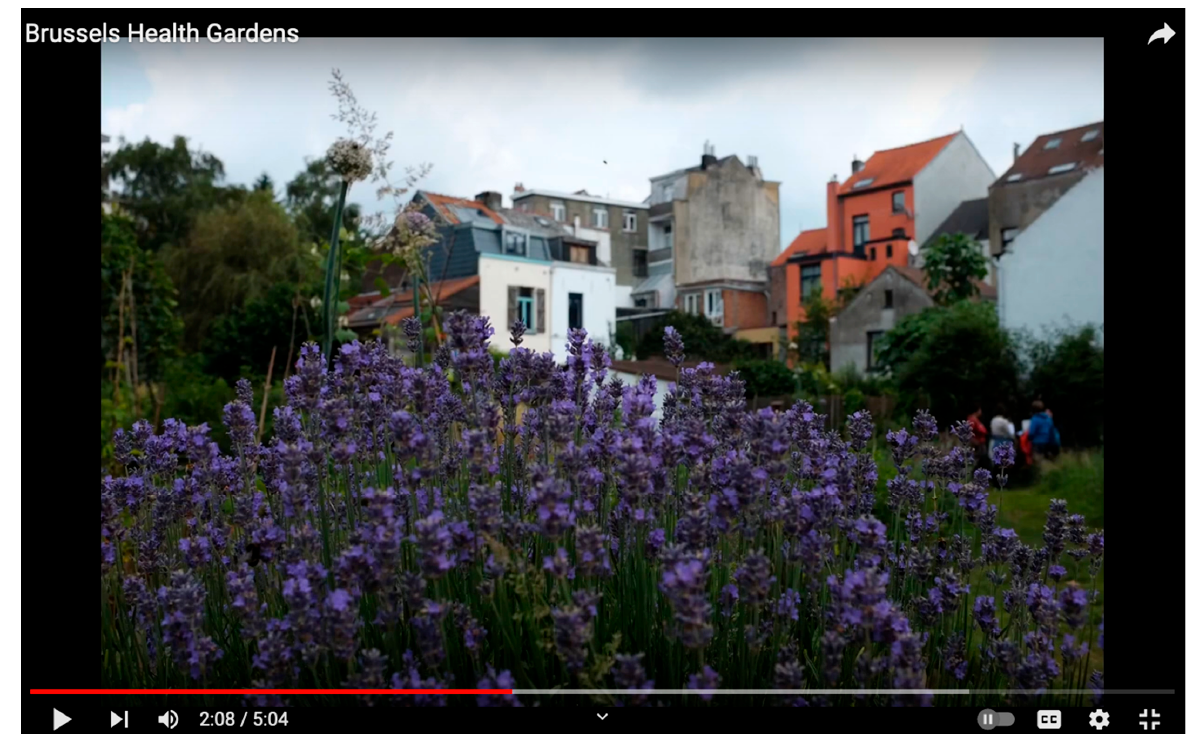
Figure 2. The screenshot of a video which presents an overview of the project in Brussels from 2019– 2021. To watch the video: